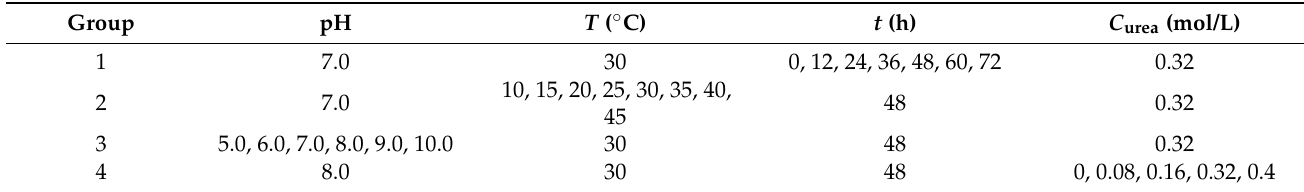
Table 1. Growing conditions of S. pasteurii .